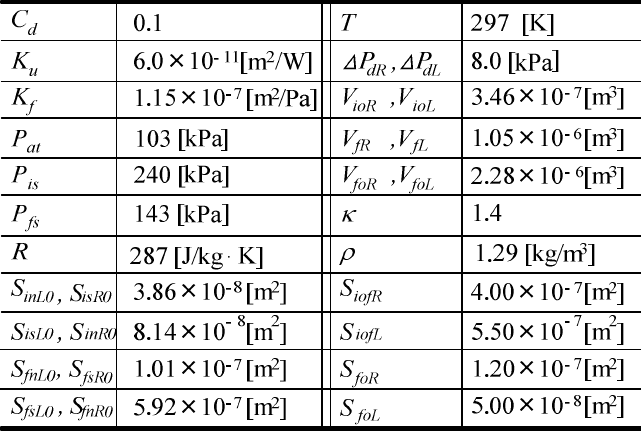
Analytical model of optical on/off device Identified system